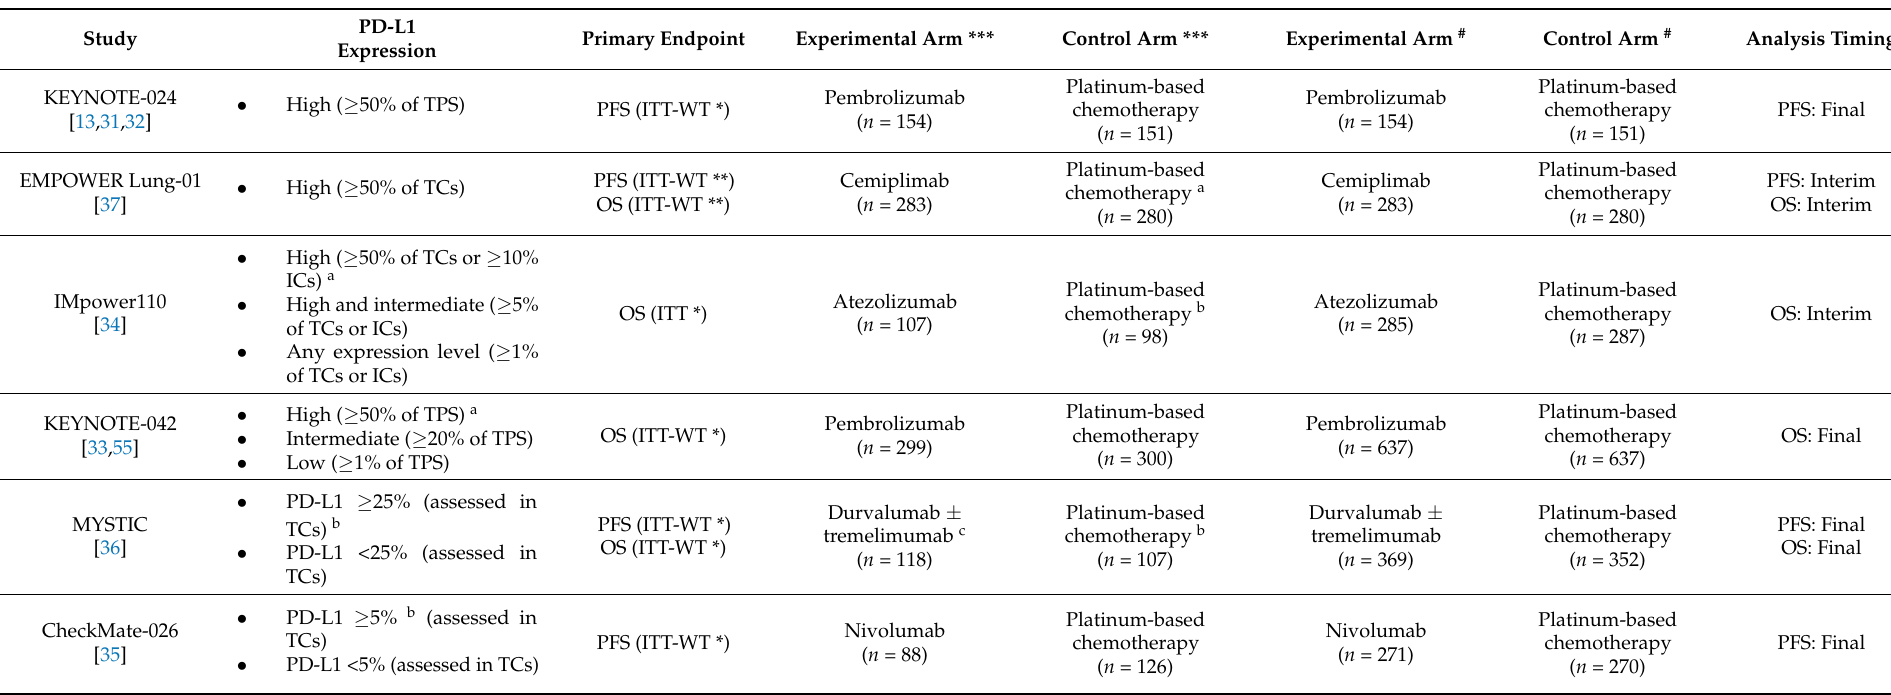
Table 1. Characteristics and main outcomes of the studies included in the meta-analysis (the most up-to-date data have been used for this network meta-analysis). PD-L1 Primary Endpoint Experimental Arm *** Control Arm *** Experimental Arm # Control Arm # Analysis Study Expression